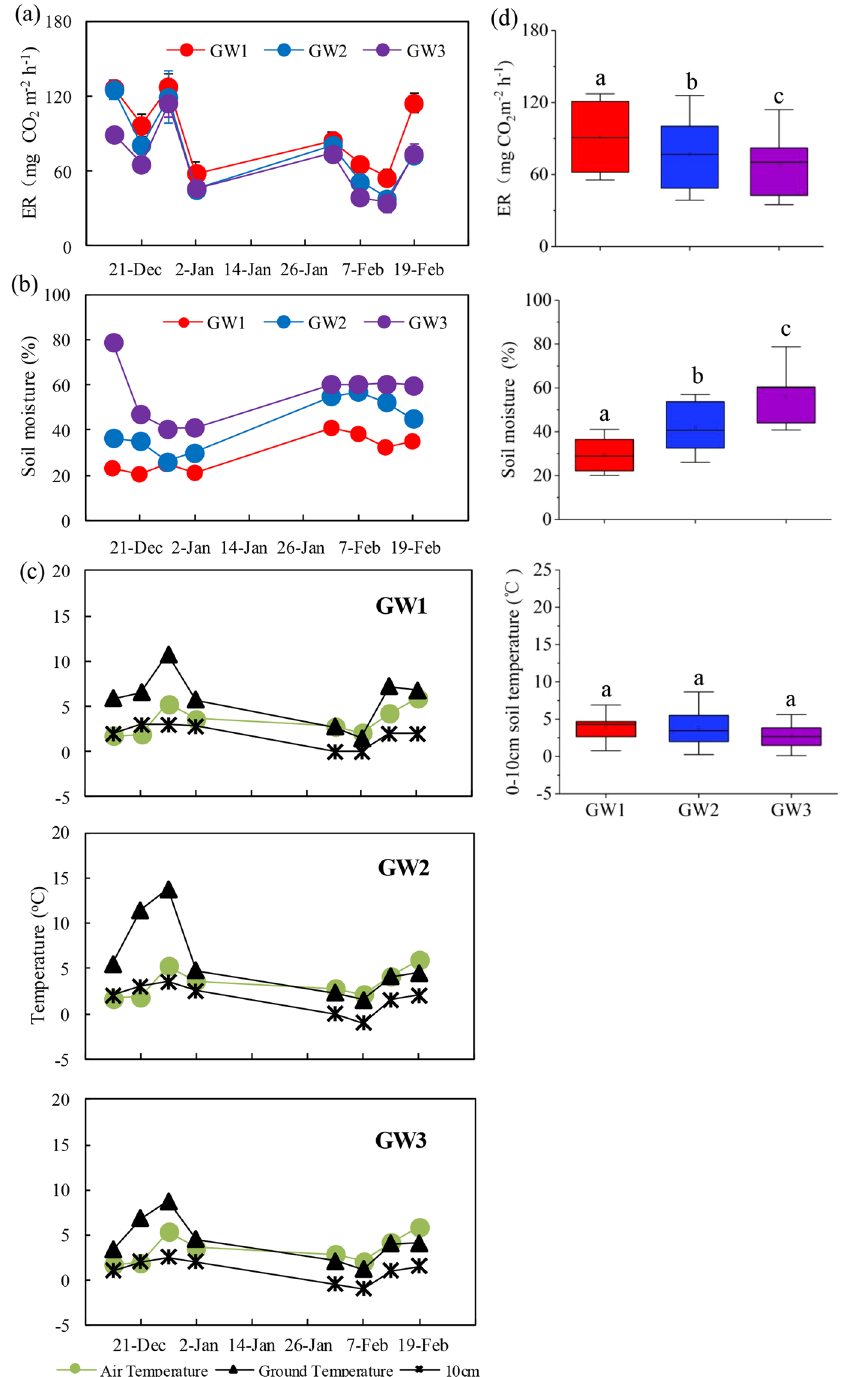
Figure 2. The summertime ER (mg CO 2 m − 2 h − 1 ± SE, n = 3) along the topographic gradient at an upland tundra. Panel (a) ER, ( b ) soil moisture, ( c ) air and soil temperature, and ( d ) The comparisons of the ER, soil moisture and soil temperature between the sites GW1, GW2 and GW3. Note: GW1, GW2 and GW3 were located at the tundra top, the middle slope and at the lower tundra slope. Error bar indicates standard error of the means (n = 3). Boxes enclose the interquartile range, whiskers show the full range. The different lowercase letters indicate statistically significant differences between the means (Fisher’s LSD, P <